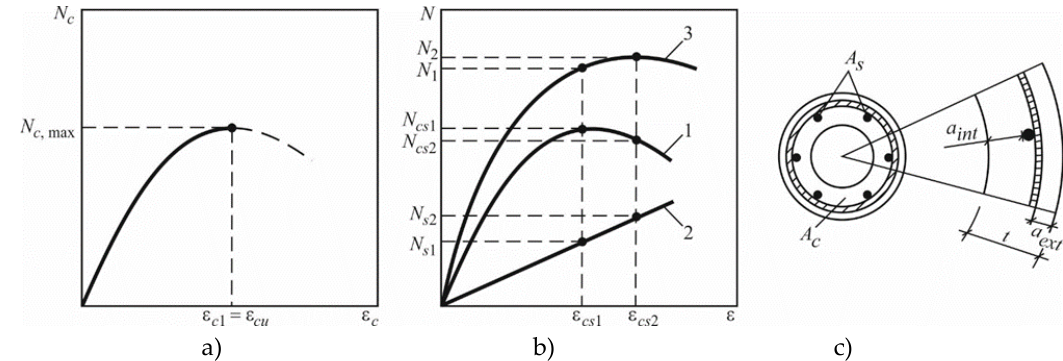
Figure 3. Representation of the force–strain relation for axially loaded members. ( a ) plain concrete; ( b ) reinforced concrete; ( c ) their cross section. 1—reinforced high-strength concrete; 2—high-strength reinforcement; 3—member.